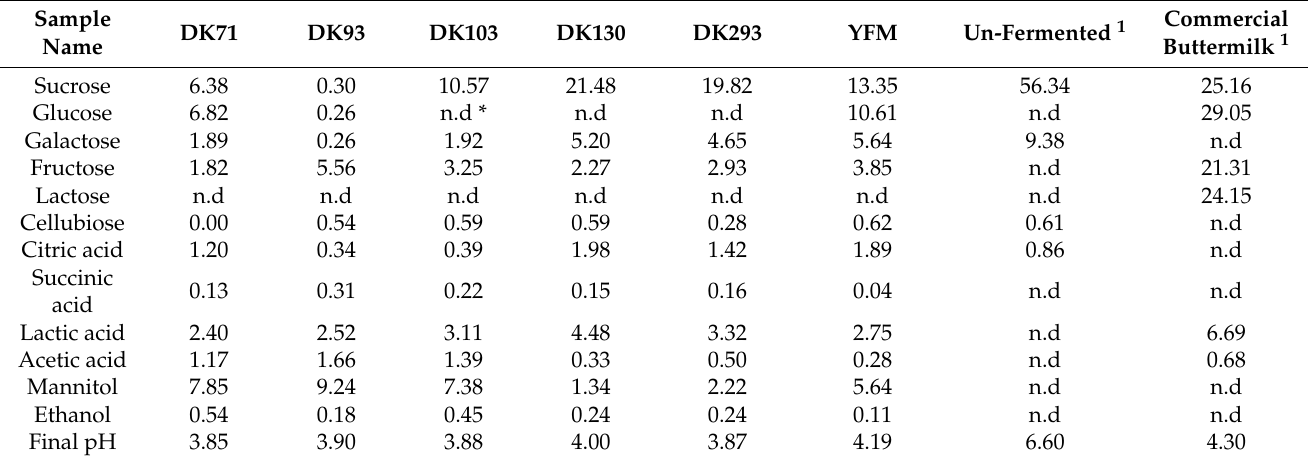
Table 4. Sugar, acid, and alcohol concentrations after fermentation. Concentrations are in